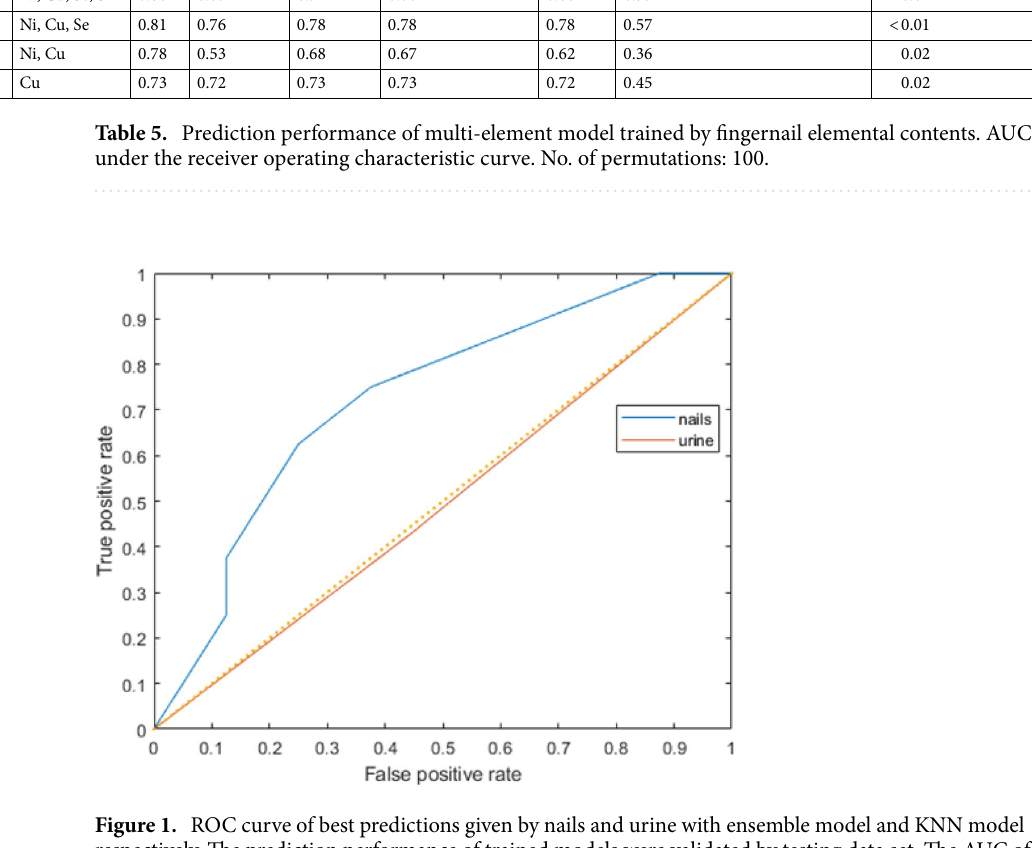
Figure 1. ROC curve of best predictions given by nails and urine with ensemble model and KNN model respectively. The prediction performance of trained models were validated by testing data set. The AUC of fingernail and urine prediction models were 0.71 and 0.49,